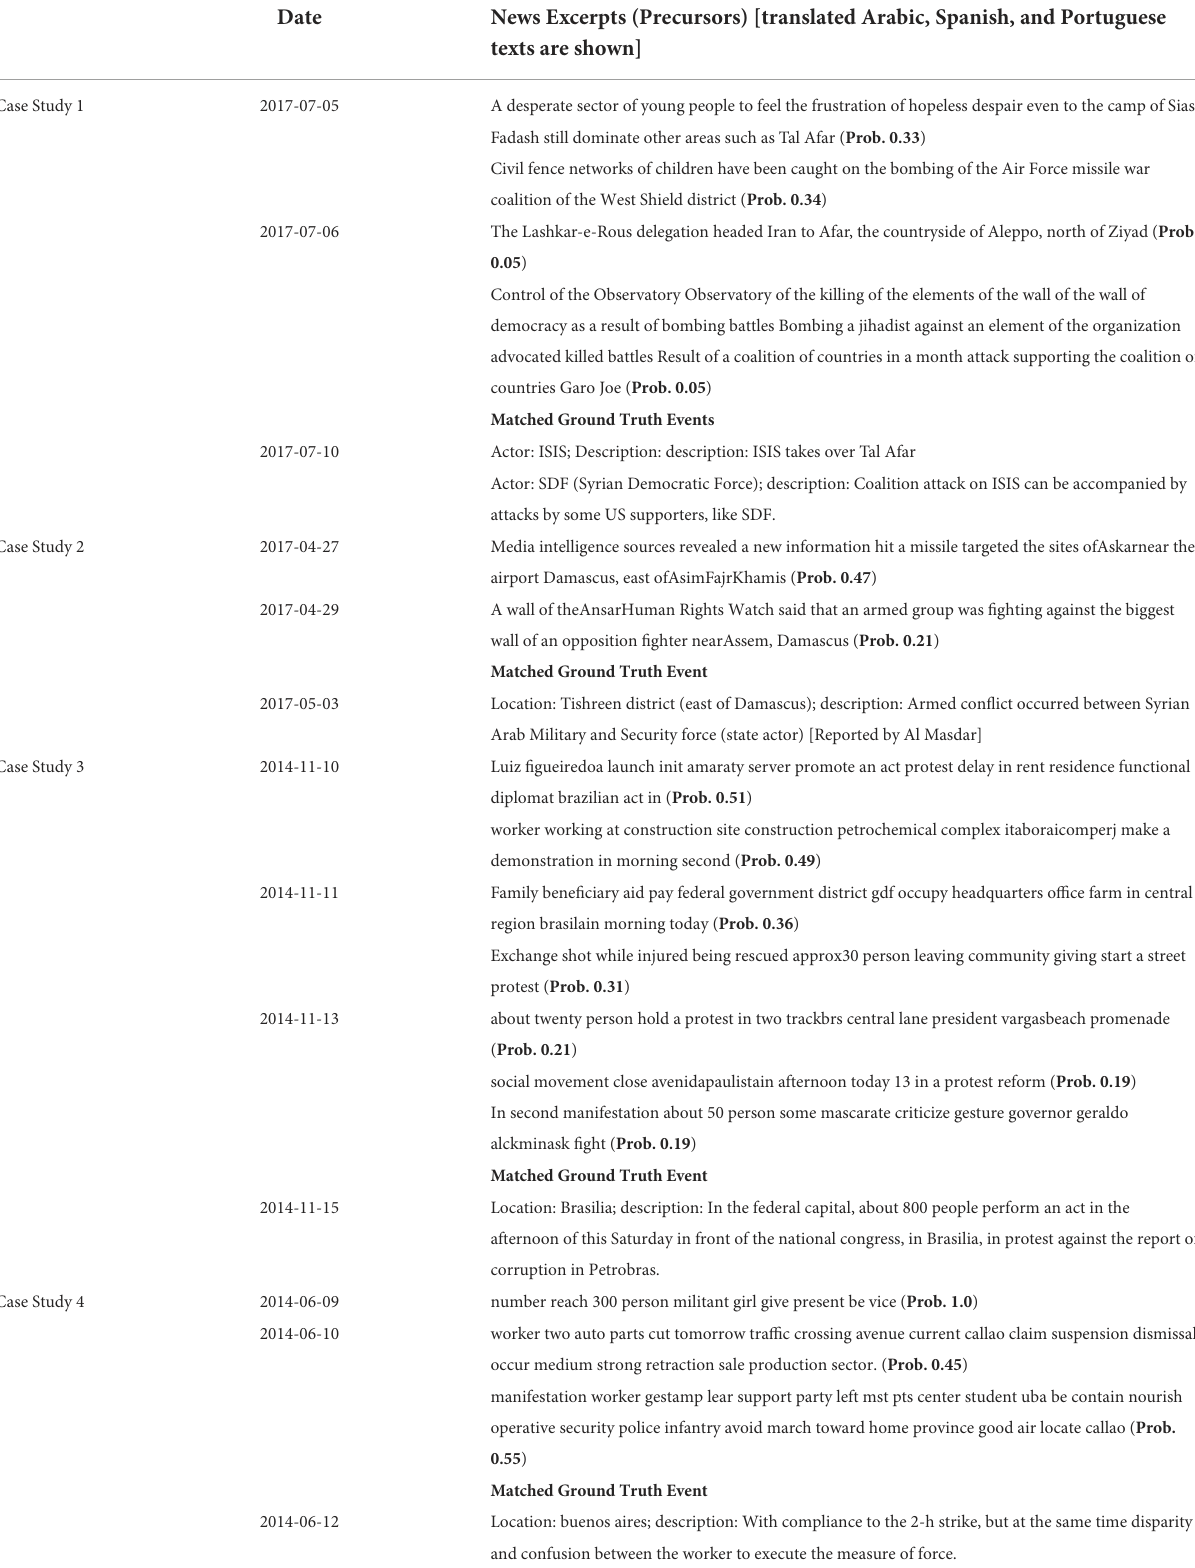
TABLE 3 Examples of anticipated